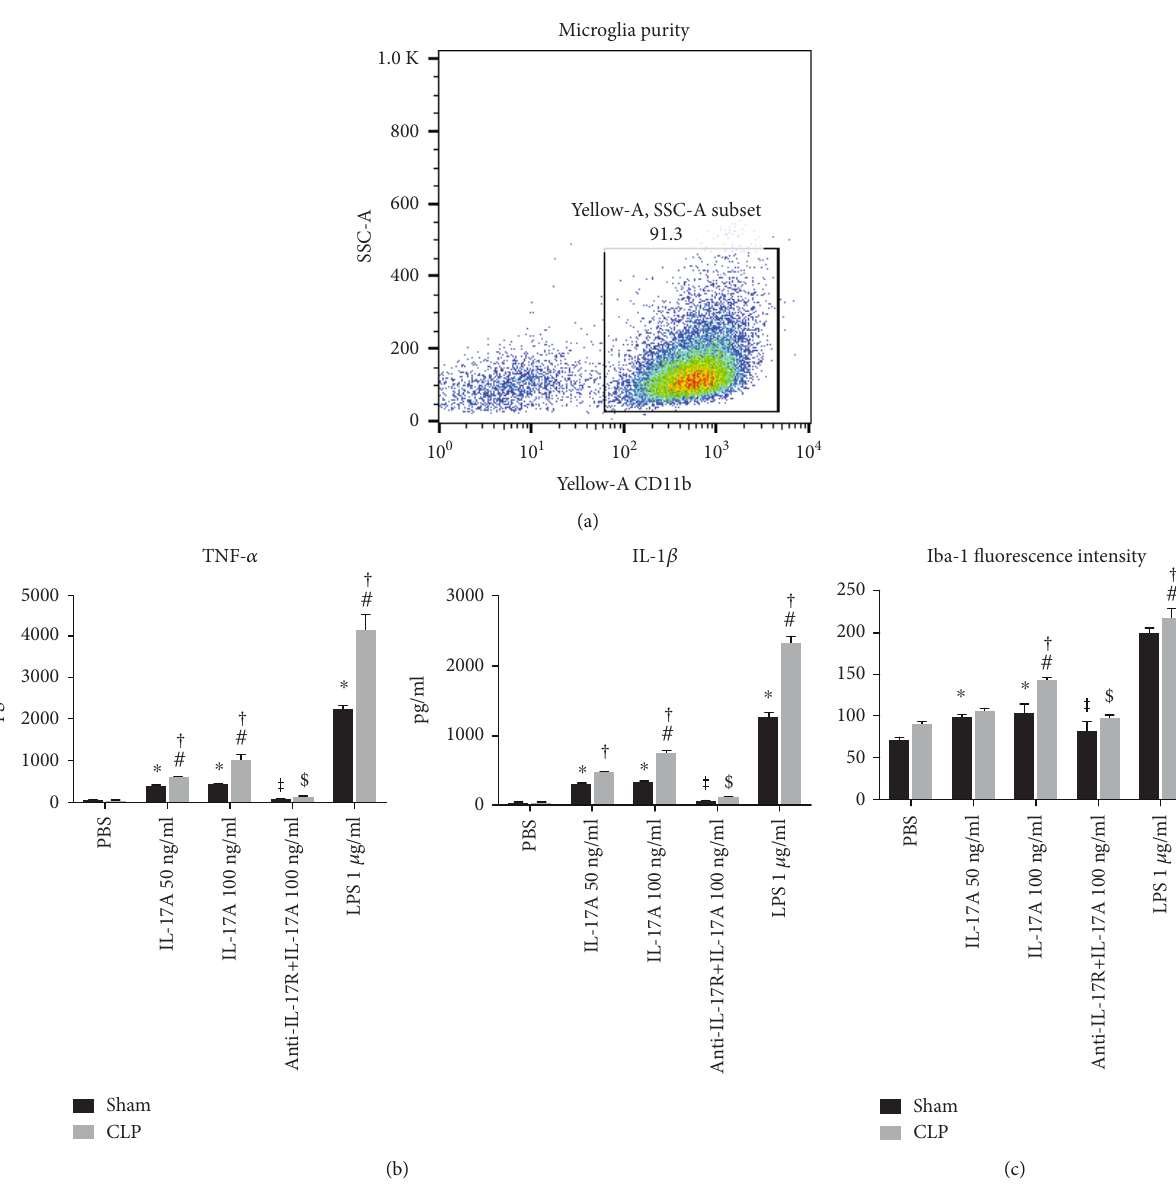
Figure 6: (a) Primary microglial cells were collected and cultured with the purity of over 90%. Cells were stained with anti-CD11b antibody and examined by fl ow cytometry. (b) IL-17A or LPS induced cytokine production in microglia in vitro. Microglia cultured from CLP or sham-operated mice was pretreated with anti-IL-17R ab or isotype control and then stimulated with or without IL-17A (50ng/ml or 100 ng/ml) or LPS (1 μ g/ml). Supernatant was collected 24 h after stimulation and measured by ELISA. (c) Mean fl uorescence intensity of Iba-1 in cultured microglia was determined by fl ow cytometry. ∗ P < 0 : 05 vs. PBS control (sham group); # P < 0 : 05 vs. PBS control (CLP group); † P < 0 : 05 CLP vs. sham; $ P < 0 : 05 vs. IL-17A 100 ng/ml (CLP group); ‡ P < 0 : 05 vs. IL-17A 100ng/ml (sham